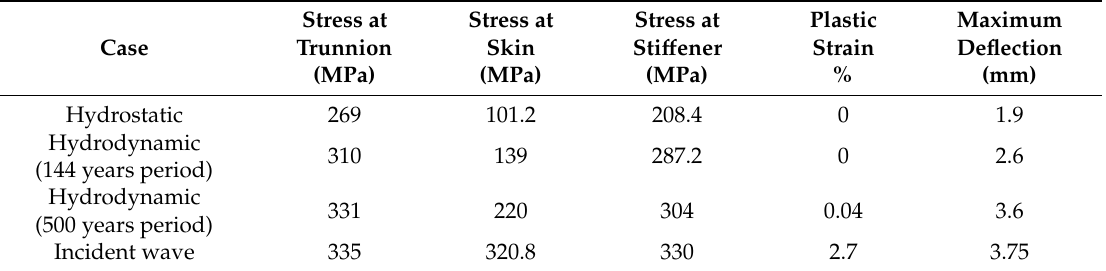
Table 4. Stresses, strain, and deflection magnitude at different loading protocols.